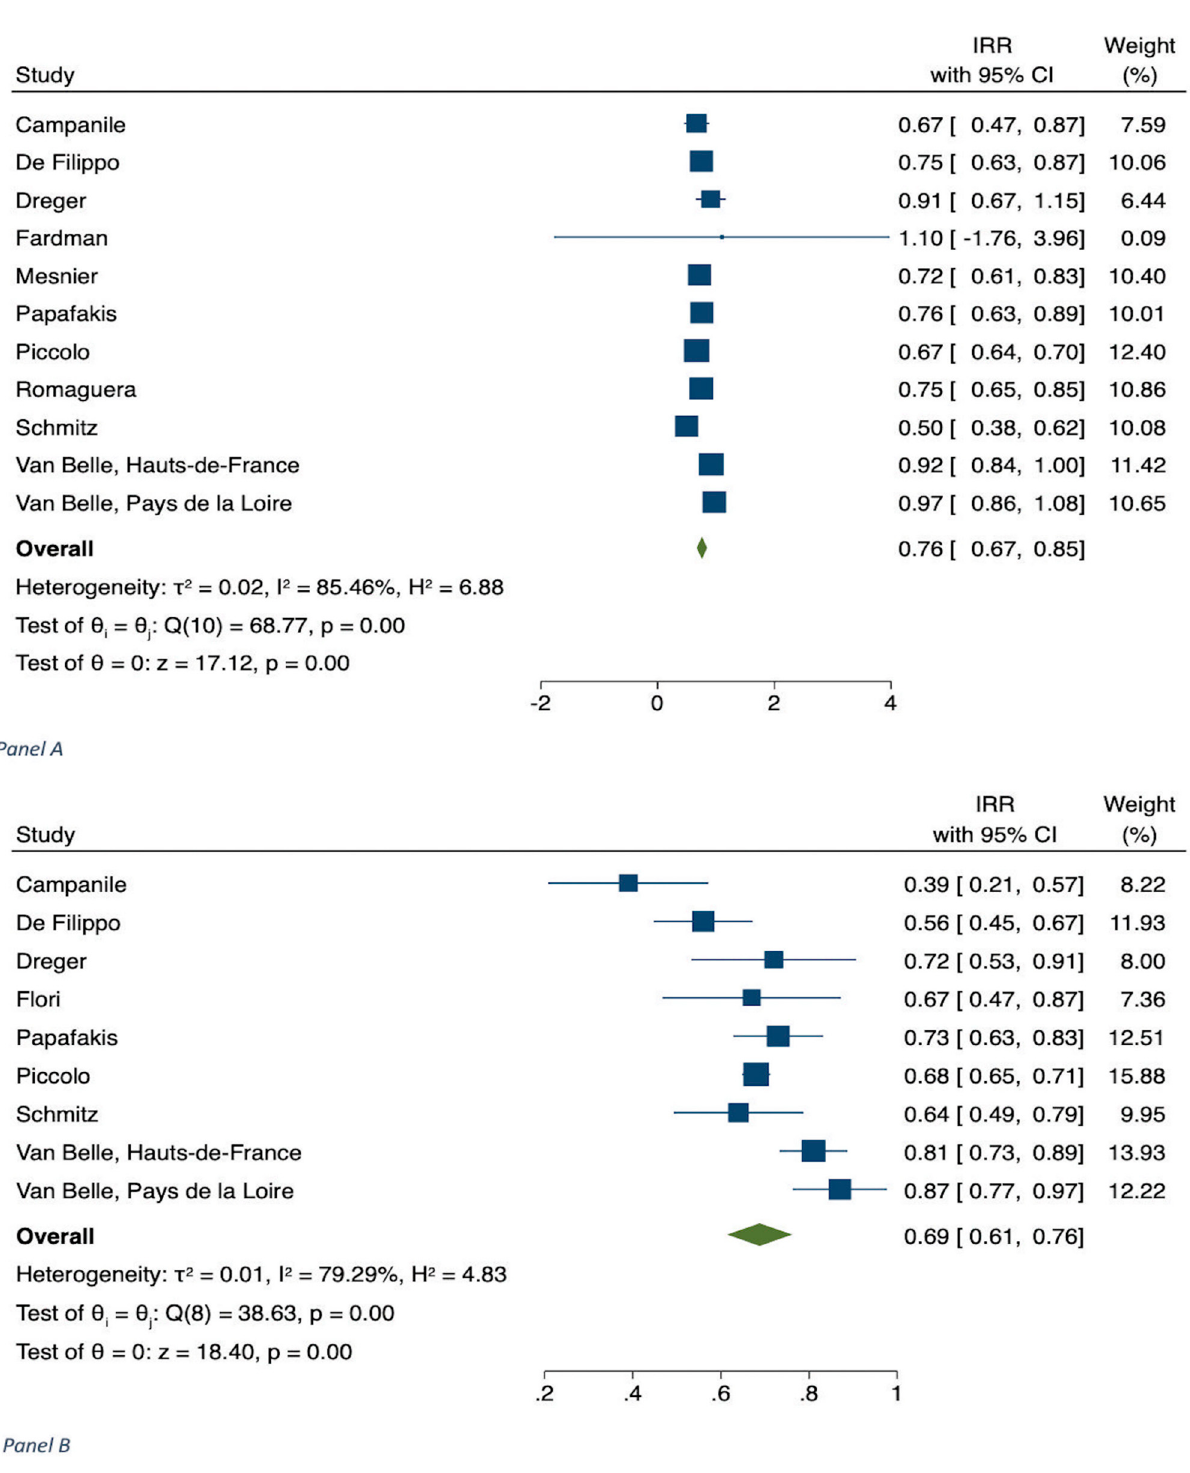
Figure 1. Panel ( A ) STEMI patients: Hospital admissions during COVID-19 pandemic in 2020 vs. corresponding control period. Panel ( B ) NSTEMI patients: Hospital admissions during COVID-19 pandemic in 2020 vs. corresponding control period.